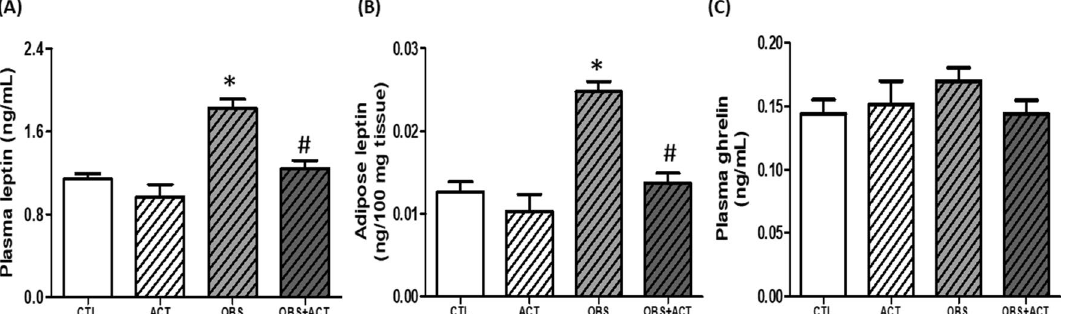
Figure 9. Effects of acetate on plasma and adipose leptin ( A , B ) and plasma ghrelin concentration in high fat diet-induced obese Wistar rats. Plasma and adipose leptin increased while ghrelin concentration remained unchanged and the alteration in leptin concentration was attenuated by the administration of acetate. Data are expressed as mean ± SD. n = 6 and analyzed by one-way ANOVA followed by Bonferroni post hoc test. (* p < 0.05 vs. CTL; # p < 0.05 vs. OBS). CTL Control, OBS Obesity, ACT Acetate.